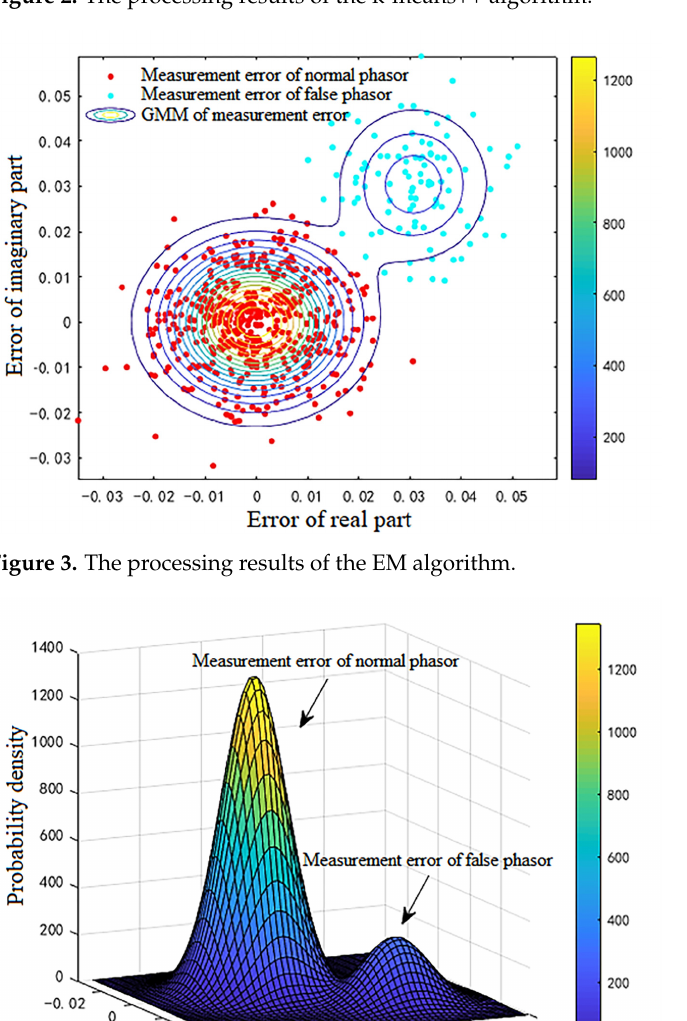
Figure 2. The processing results of the k-means++ algorithm.